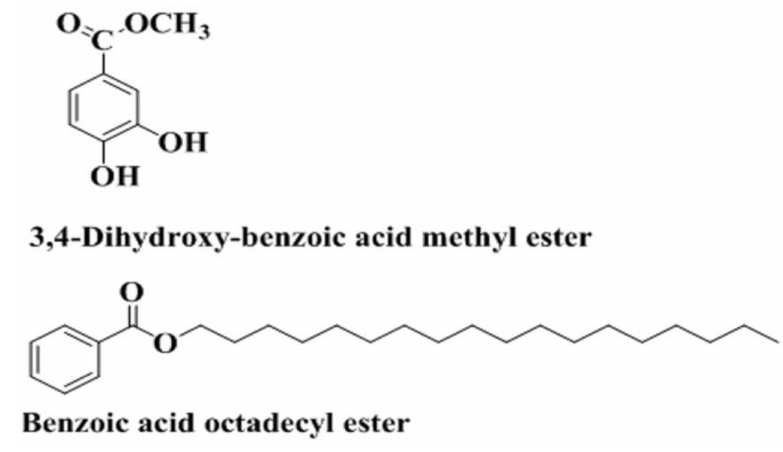
Figure 1. Chemical structures of the isolated compounds.